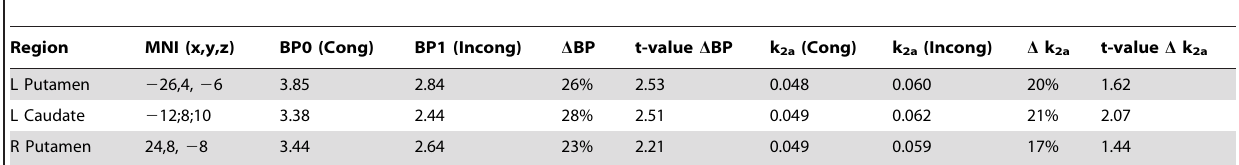
Table 2. Receptor kinetic parameters measured before (Congruent condition) and after (Incongruent condition) task initiation.